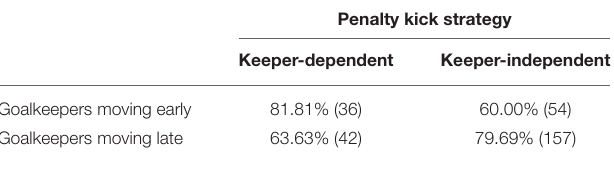
TABLE 1 | Scoring rates and number of converted penalties (in brackets) as a function of penalty kick strategy (keeper-dependent vs. keeper-independent) and goalkeeping strategy (early vs. late